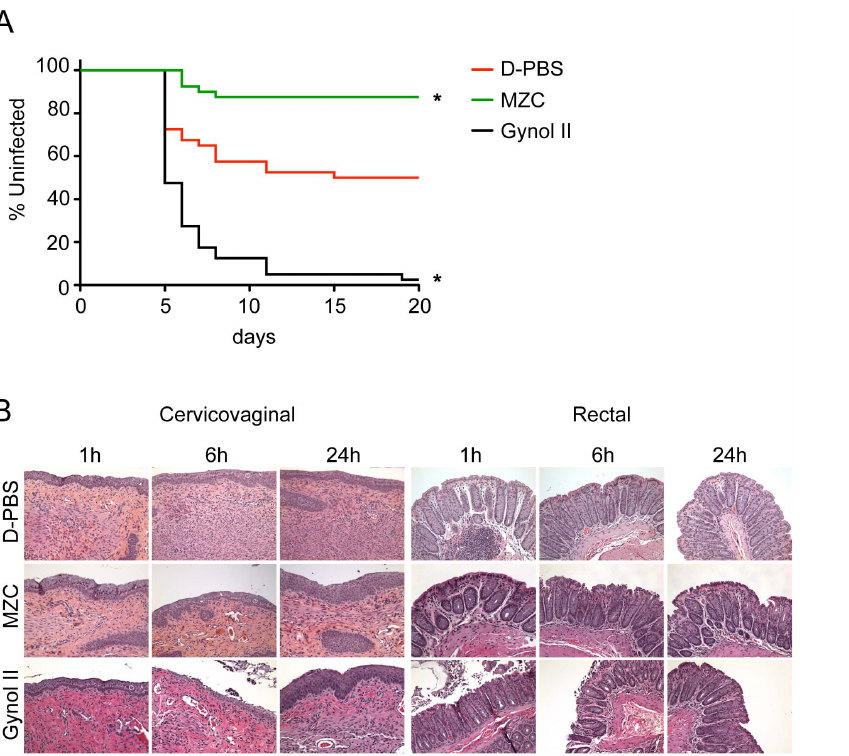
Figure 2. Invivo application of MZC does not compromise epithelial integrity or increase HSV-2 susceptibility. A) HSV-2 enhancement model. Balb/C mice (n=40 per group) were depo-treated 7 d before starting vaginal application of each formulation daily for 7 d, followed by HSV-2 G challenge 12 h post-last gel. Percent of uninfected animals over time is shown (*P , 0.05 vs. D-PBS, Fisher’s exact test). B) Epithelial integrity testing. Depo-treated (vaginal dosing) and fasted (rectal dosing) mice were treated with MZC, D-PBS, or Gynol II. At 1, 6 and 24 h post-application, mice were euthanized, and the entire reproductive or rectal tract was surgically excised for morphological analysis. Pictures (20 6 magnification) are representative of six sections from two to three animals per